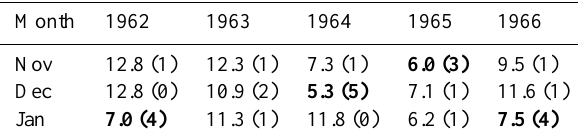
Table 4. Monthly A p indices and number (in parenthesis) of nega- tive Q-disturbances observed at Slough for three months and years around solar minimum. Months with low A p are marked